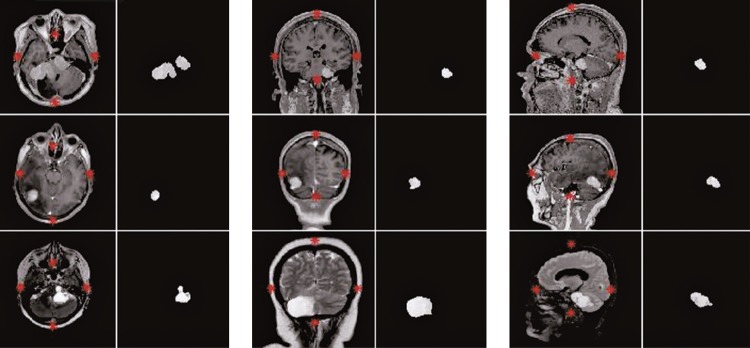
Resultado final da segmentação automática em imagens de ressonância magnética na ponderação T1, T2 e T1 com contraste na sequência gradiente eco com uso de spoiller